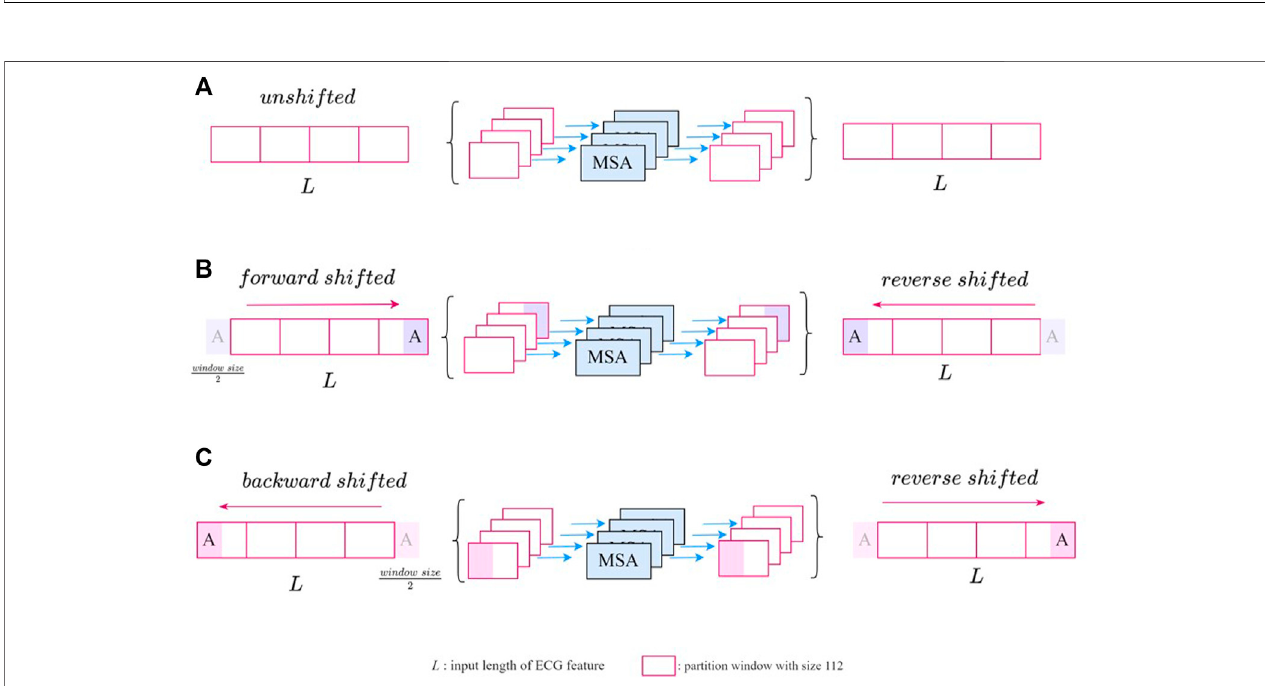
FIGURE 4 | The illustration of SW-MSA module with (A) unshifted (B) forward-shifted, and (C) backward-shifted.